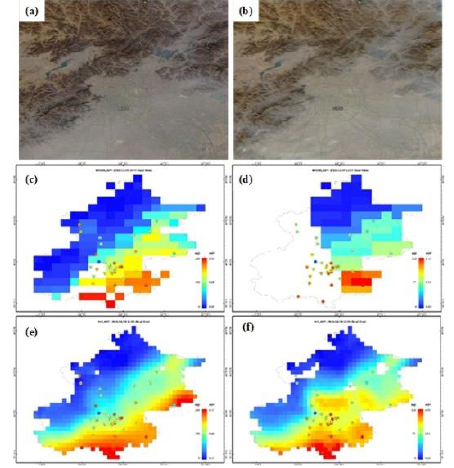
Figure 10.a case of spatial distribution of aerosol loading on 30 November